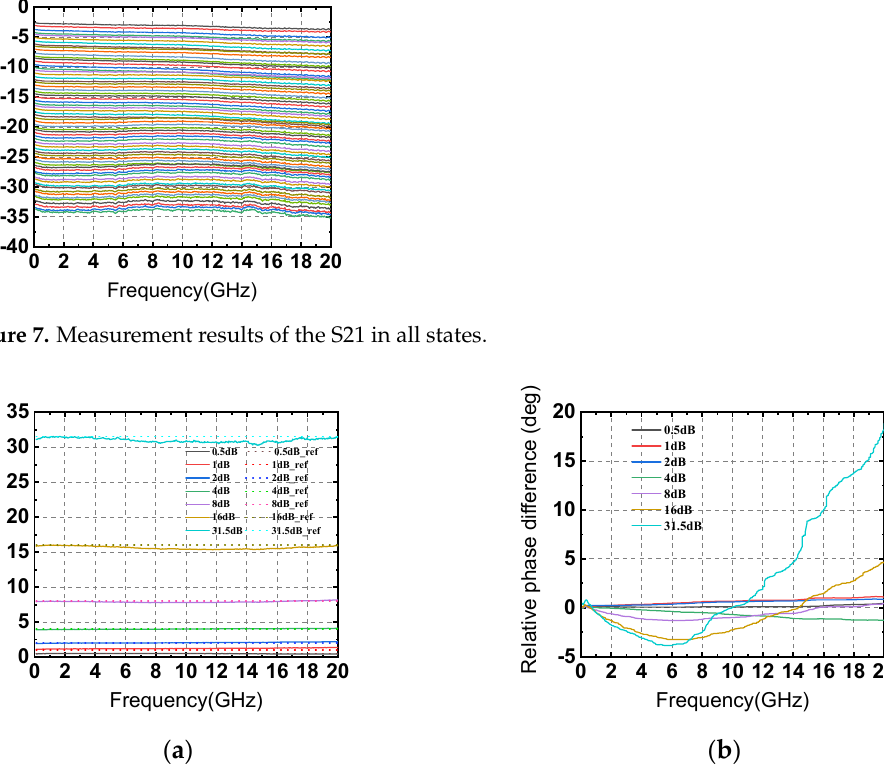
Figure 6. The diagram of the measurement setup.